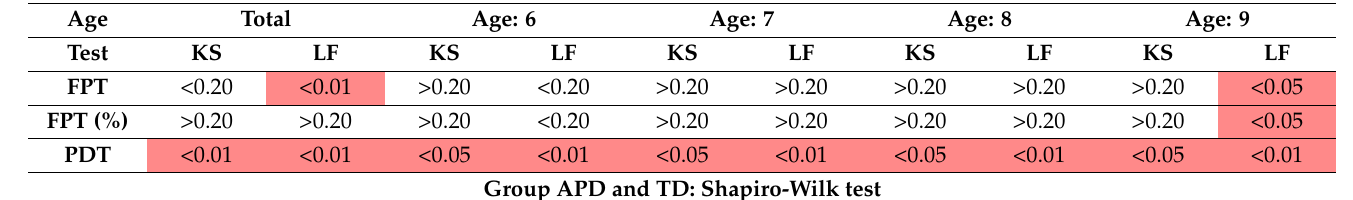
Table A2. Cont. Group TD: Kolmogorov–Smirnov test and Lilliefors test